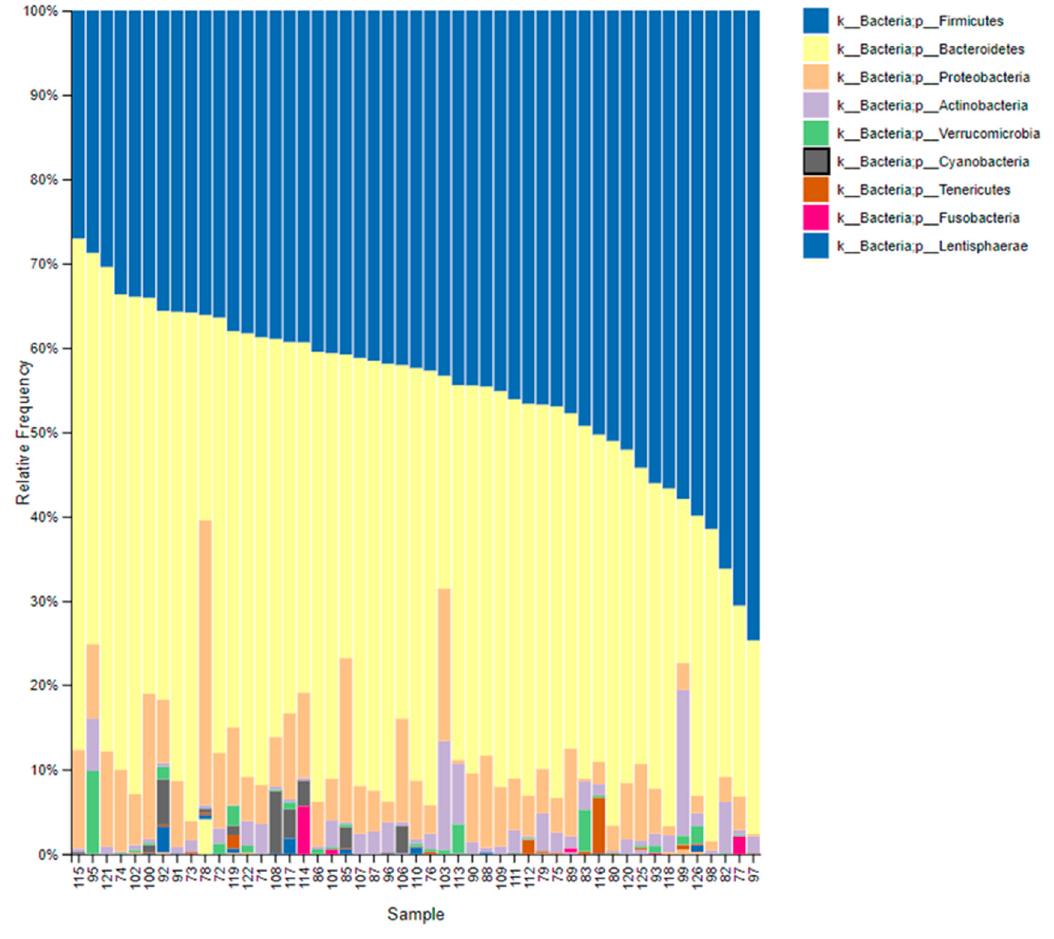
Figure 3. Baseline gastrointestinal microbiome composition. Taxonomic composition of the gastrointestinal communities at the beginning of the intervention. The figure shows bar charts of the relative abundance of bacteria at the phylum level. Each column represents a participant.